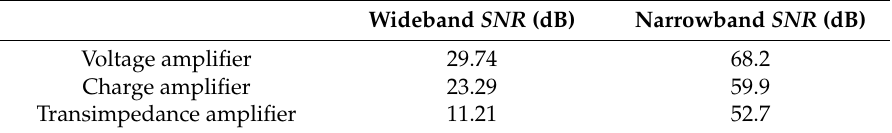
Table 1. Signal-to-noise ratio ( SNR ) for all considered topologies measured with 500 kHz and narrow bandwidth.